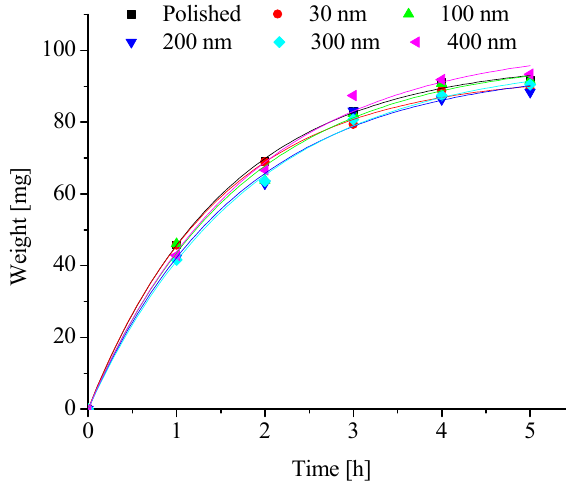
Figure 29. Testing value exponential model regression fitting at T = − 15 °C, φ = 90%.